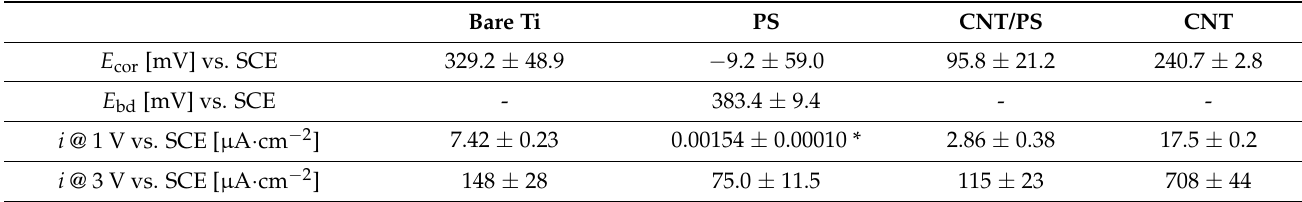
Table 3. Potentiodynamic polarization results in the form of corrosion